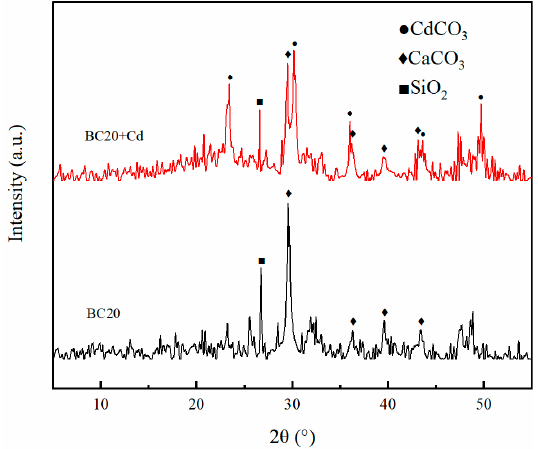
Figure 10. XRD patterns of BC20 before and after Cd 2+ adsorption.